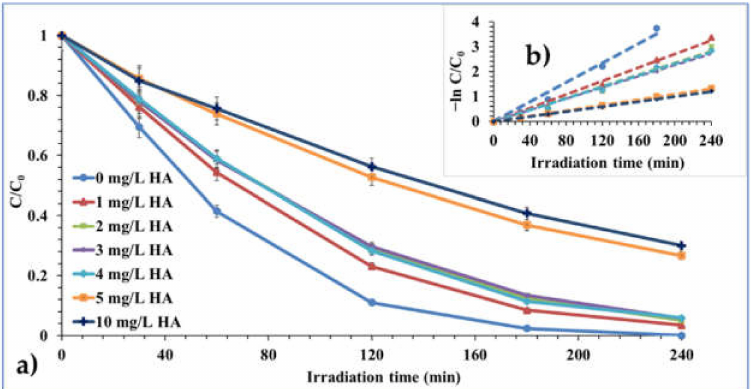
Figure 17. ( a ) HA effect on the photocatalytic degradation performance of 1 g/L Mo/SynTiO 2 over 5 mg/L initial CBZ concentration under natural (unmodified) pH 5.84, and 365 nm irradiation; and ( b ) their corresponding photocatalytic degradation rate constant